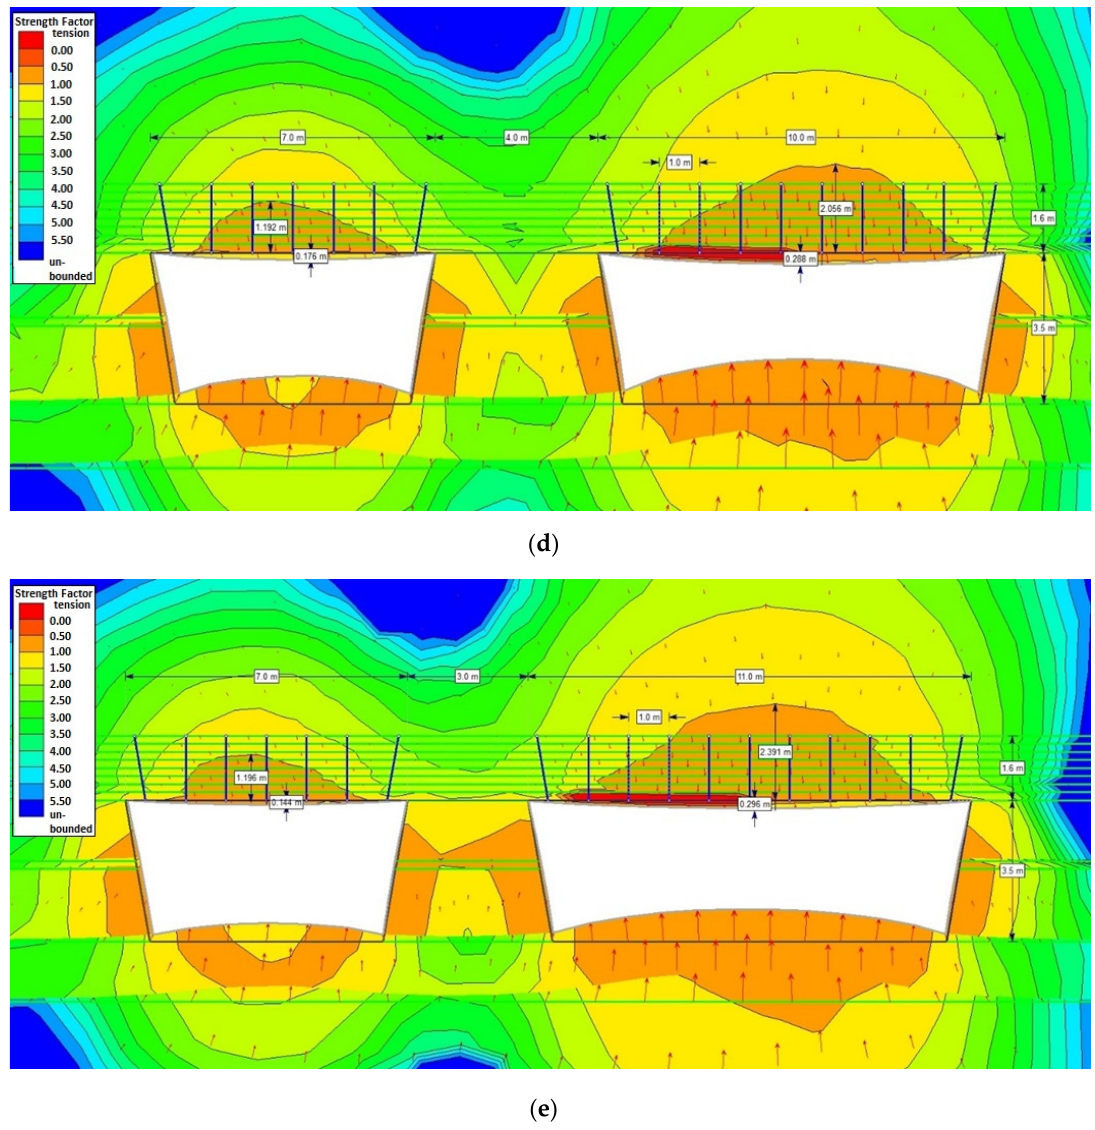
Figure 15. Maximal total displacement of roof rocks with net bolting 1 m × 1m, for room and pillar